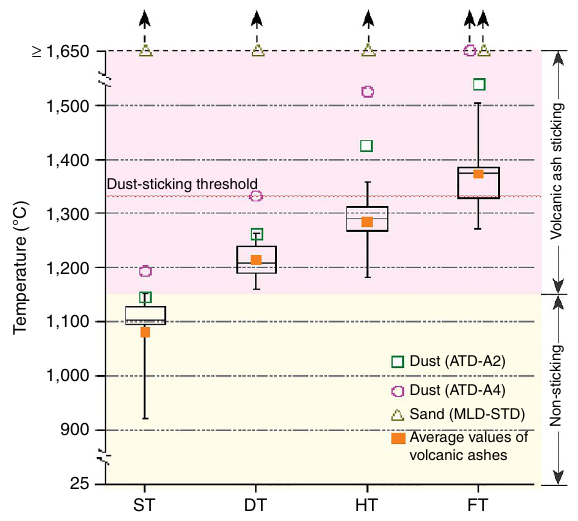
Figure 4 | Thermal constraints on particle behaviour at high temperatures. The range of values of ST, DT, HTand FTof nine volcanic ash samples are represented in this box-and-whisker plot, together with those of the two standard dusts and one standard sand. The lower and upper sides of each box indicate the 25th and 75th percentiles, respectively. Inside the boxes, the solid lines indicate the median and the orange squares indicate the mean of the characteristic temperatures of the nine volcanic ash samples. Outside the boxes, small tick marks indicate minimum and maximum values. Note that some of the characteristic temperatures of sand and dust exceed the operational limit of our heating microscope (1,650 (cid:2) C), yet these clearly supersede the low-temperature range of sticking ability of volcanic